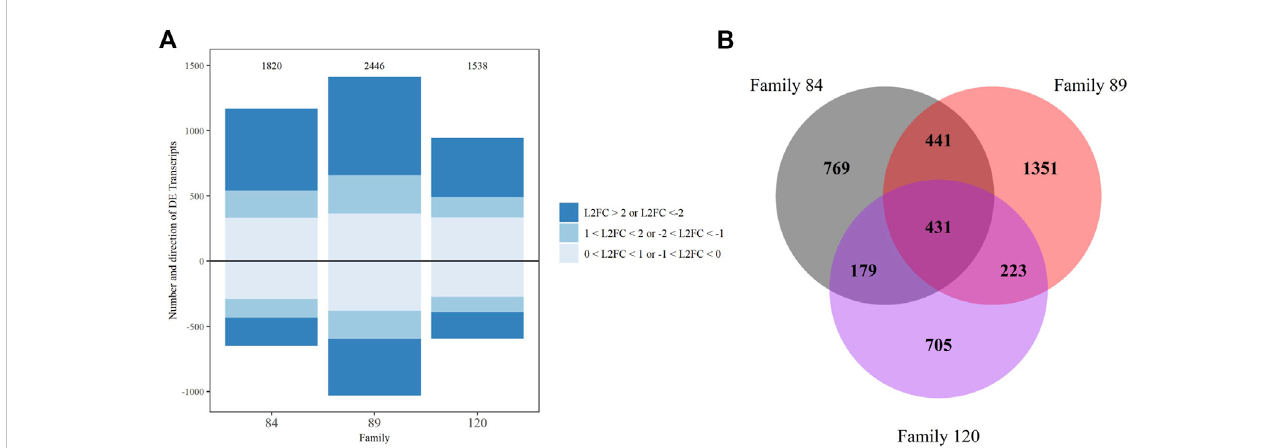
FIGURE 4 DESeq2 differential expression analysis results for family comparisons with family 90 as the reference, transcripts with false discovery rate corrected p -value < 0.05 were considered signi fi cant. (A) Up and downregulated transcripts and their Log2 foldchange intensity, the total number is noted above each bar. (B) Venn diagram depicting overlap between comparisons.